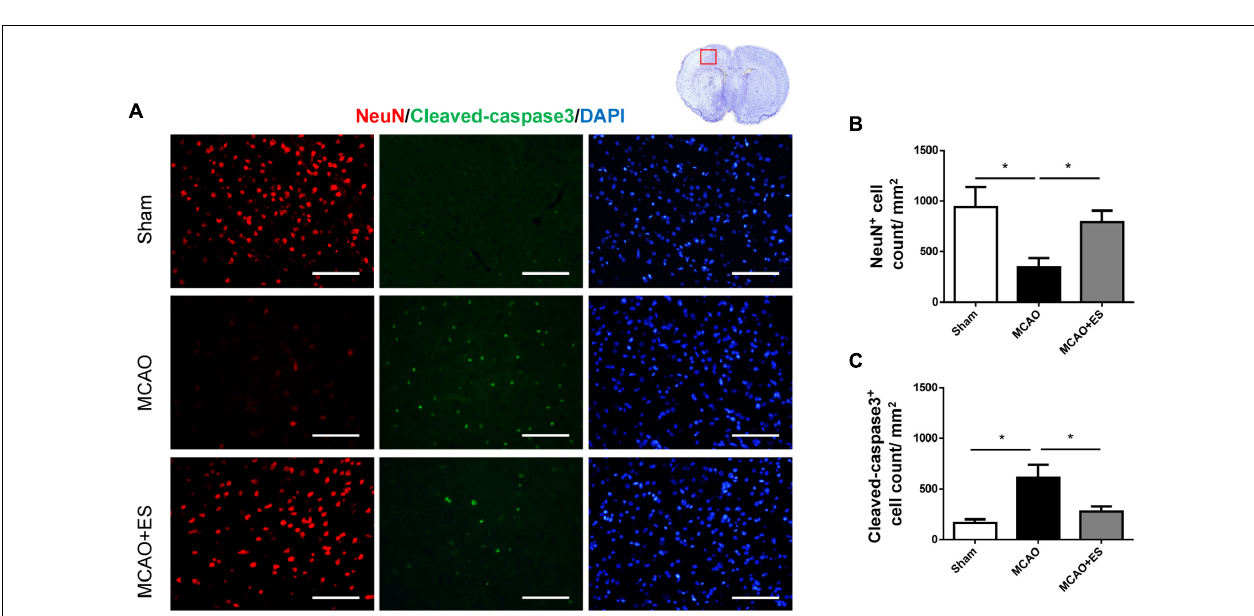
FIGURE 3 | Electrical stimulation treatment inhibits neuronal cell death of the brain in the MCAO animal model. (A) Representative pictures of immunofluorescence stains for NeuN (red fluorescence), cleaved caspase-3 (green fluorescence), and DAPI (blue fluorescence). The red blocked box in the top-right panel represents views in the penumbral region. (B) Quantitative analysis for NeuN immunoreactive cells. The ES group shows significantly higher neurons survival than the control group. (C) Quantitative analysis shows a significantly reduced number of immunoreactive cells for cleaved caspase-3 in the ES group, demonstrating the antiapoptotic effect of ES (Sham n = 5; MCAO n = 10; and MCAO + ES n = 10; scale bar = 50 µ m). * p < 0.05.